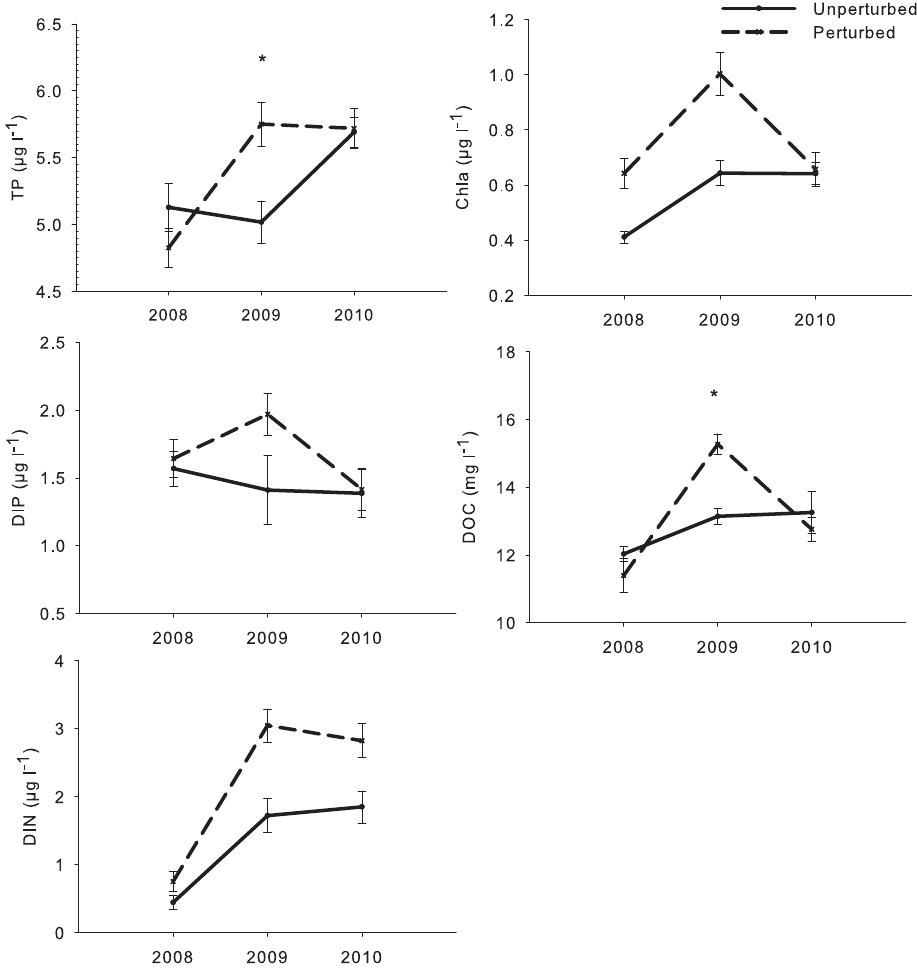
Figure 2. Comparison between treatments (unperturbed, perturbed) and years (2008, 2009, 2010) of TP, DIP, DIN, chl a and DOC. Vertical bars represent standard errors. ∗ p < 0 .